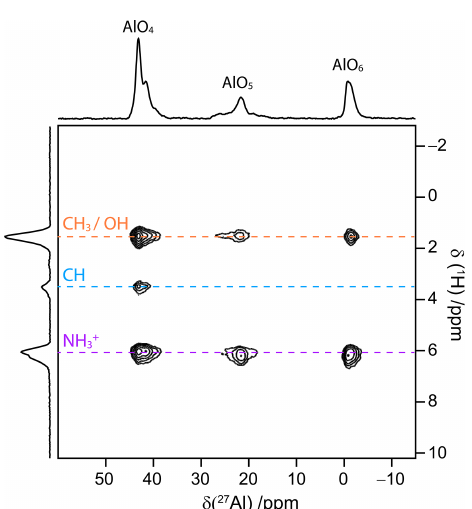
Figure 9. The 1 H– 27 Al D -HETCOR 2D spectrum of AlPO 4 - 14, along with its skyline projections, at B 0 = 18.8T and ν R = 62 . 5kHz acquired in only 72min with only ca. 2.5µL of active vol- ume with NUS 25% using RINEPT-CWc-SR4 2